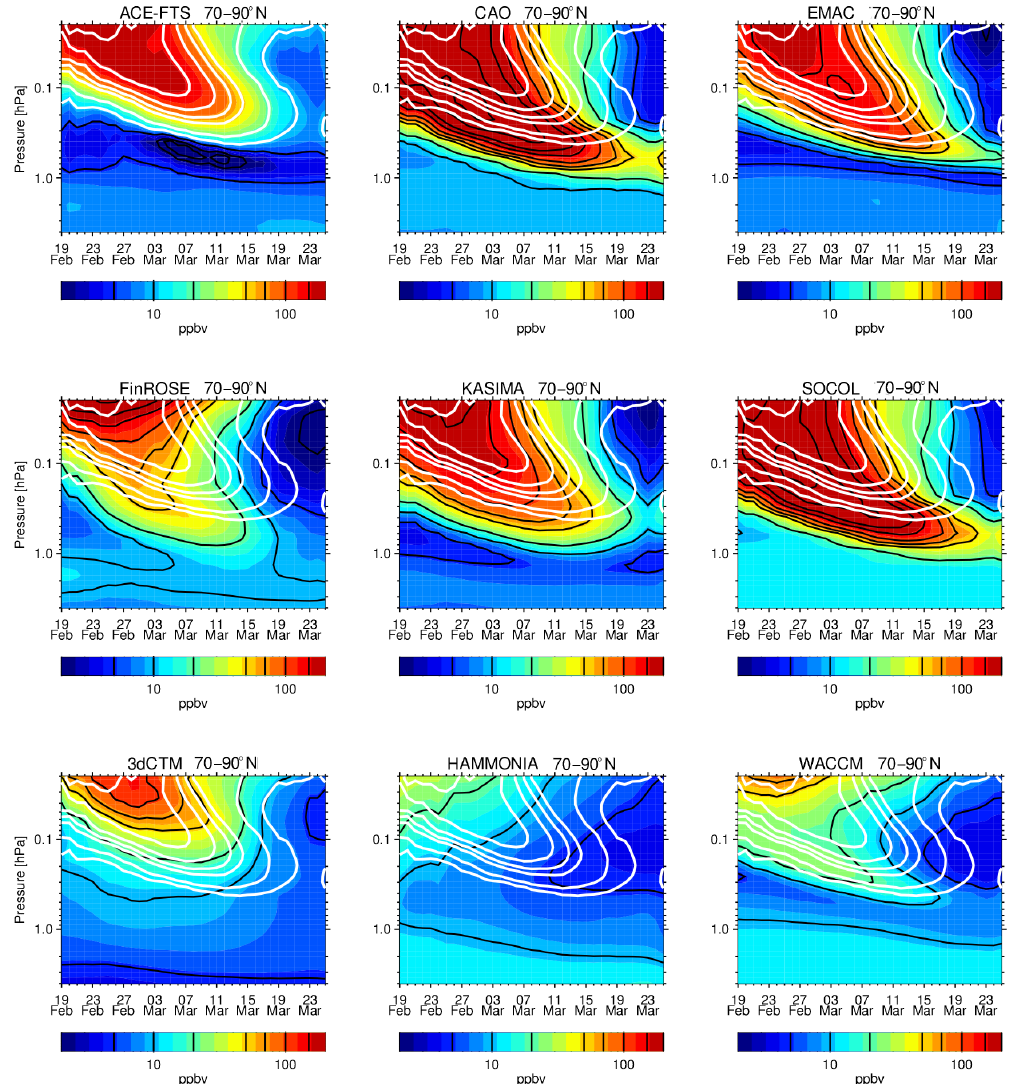
Figure 15. Same as Fig. 14, but for ACE-FTS.